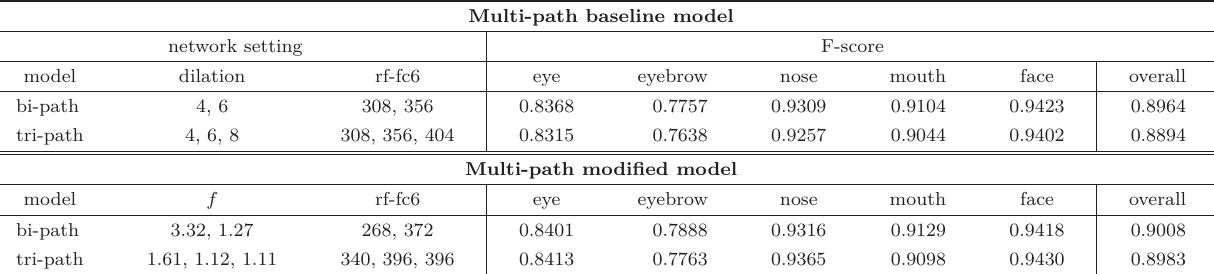
Table 4 Quantitative evaluation of multi-path versions of baseline models and modified models using Helen dataset [7, 8]. Each parallel path in the modified network was initialized with a dilation value of